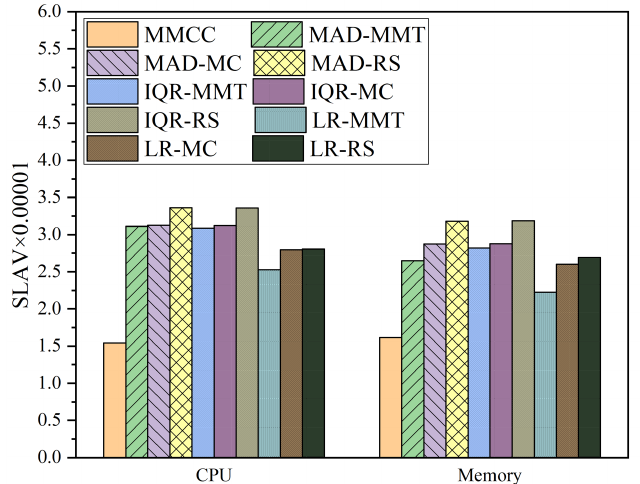
Figure 10. Comparing the SLAV by all methods regarding CPU and memory.